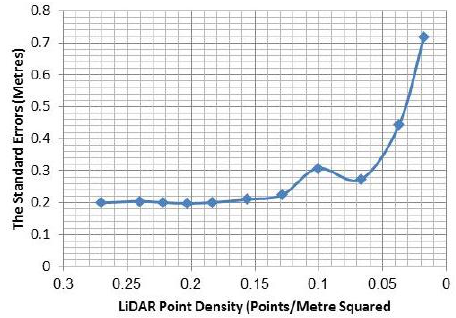
Figure 23. The ranges of the elevation residuals against LiDAR point cloud density.